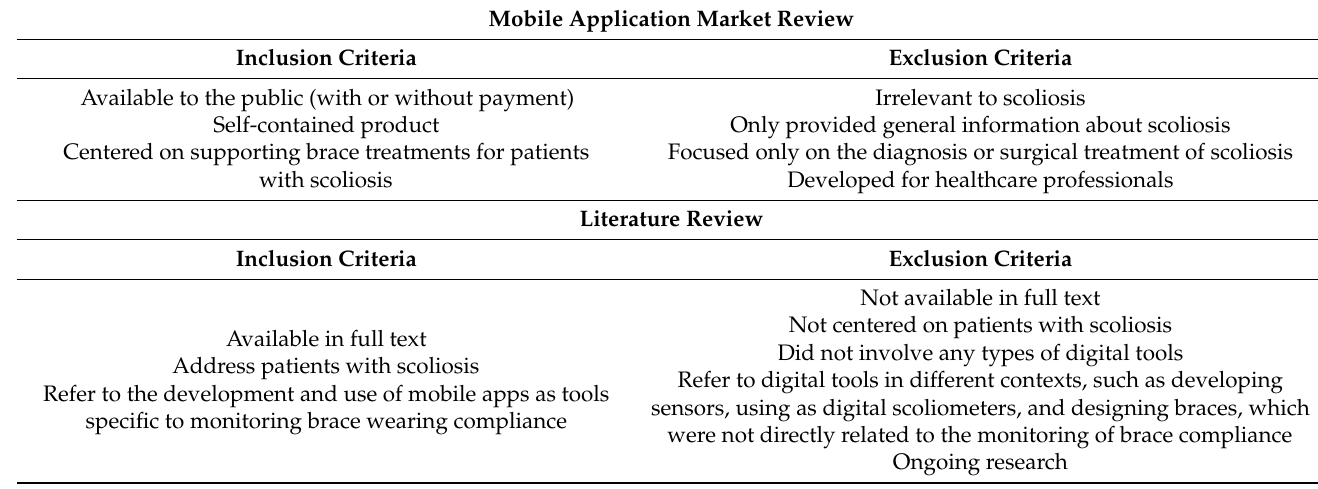
Table 1. Inclusion and exclusion criteria for commercial mHealth apps and articles in the final